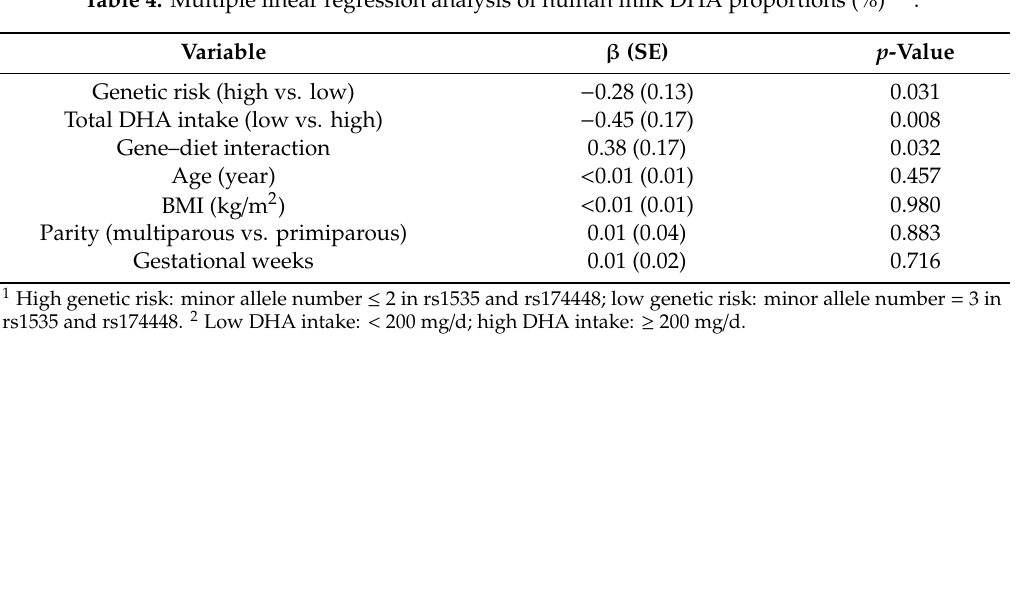
Table 4. Multiple linear regression analysis of human milk DHA proportions (%) 1.2